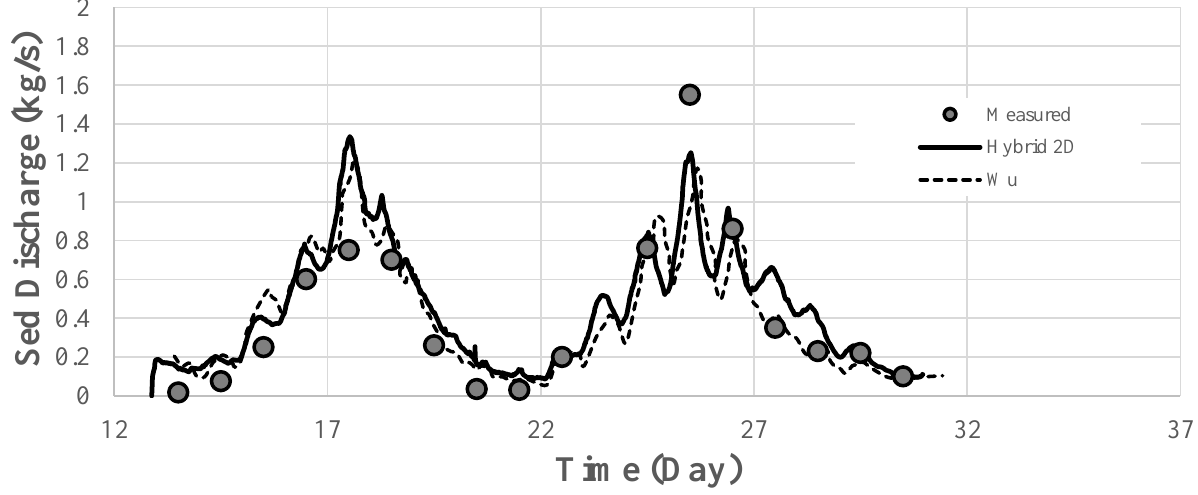
Figure 10. Sediment discharge at the outlet.